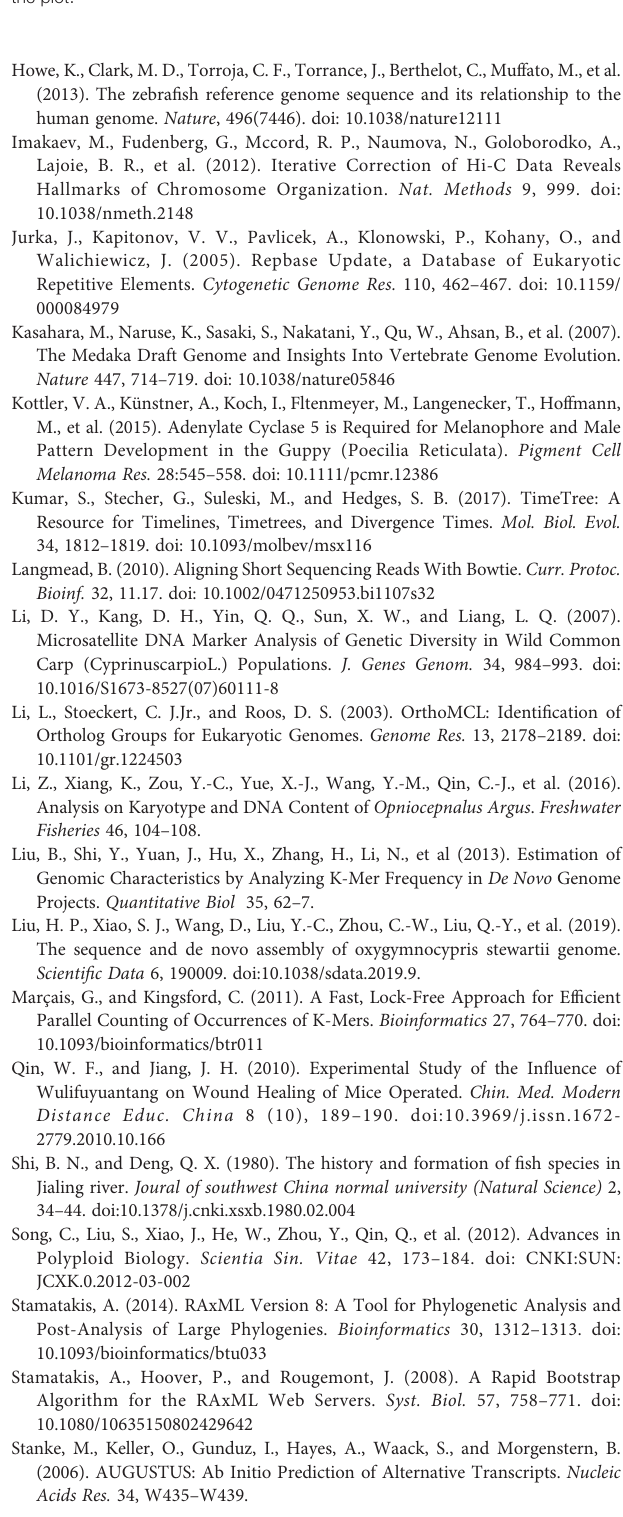
number (blue line) and by length (blue heatmap), LINE density by number (red line) and by length (red heatmap), LTR density by number (green line) and by length (green heatmap), all repeat density (yellow) with tandem repeat density (purple). The inter-chromosome segment duplications were illuminated in the inner of the